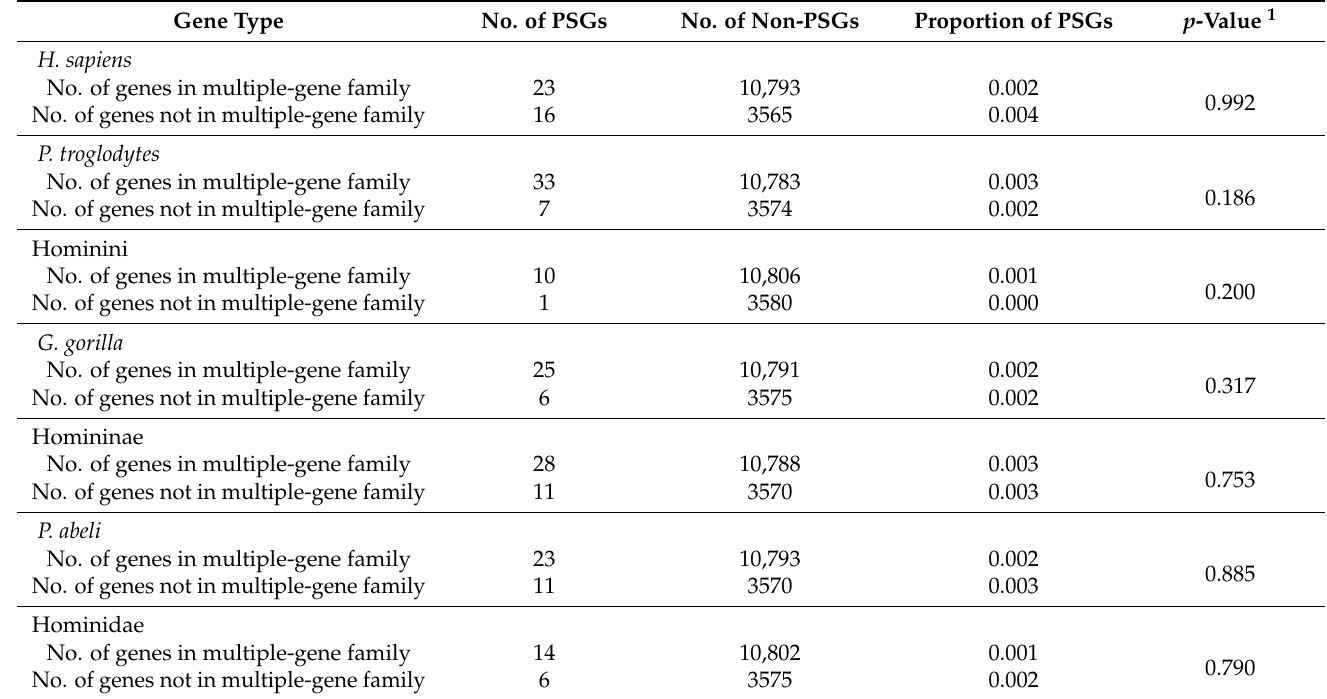
Table 5. Association of PSGs with multigene